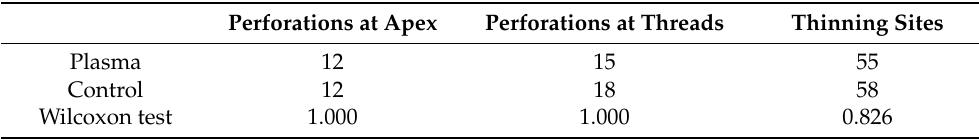
Table 2. Number of perforations and thinning mucosa sites. Perforations at Apex Perforations at Threads Thinning